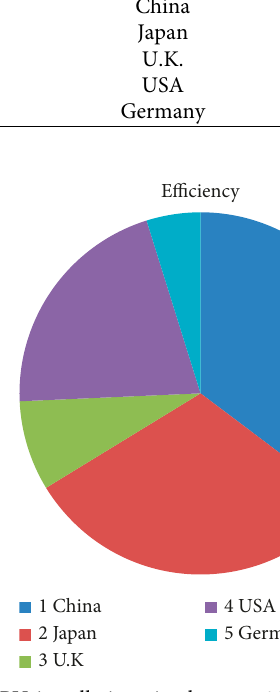
Figure 8: PV installations in the year 2014 for different leading